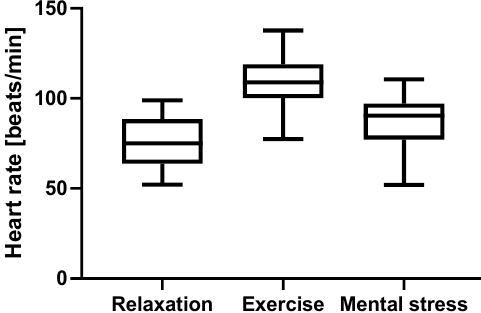
Figure 4. Average heart rate for all participants during the different